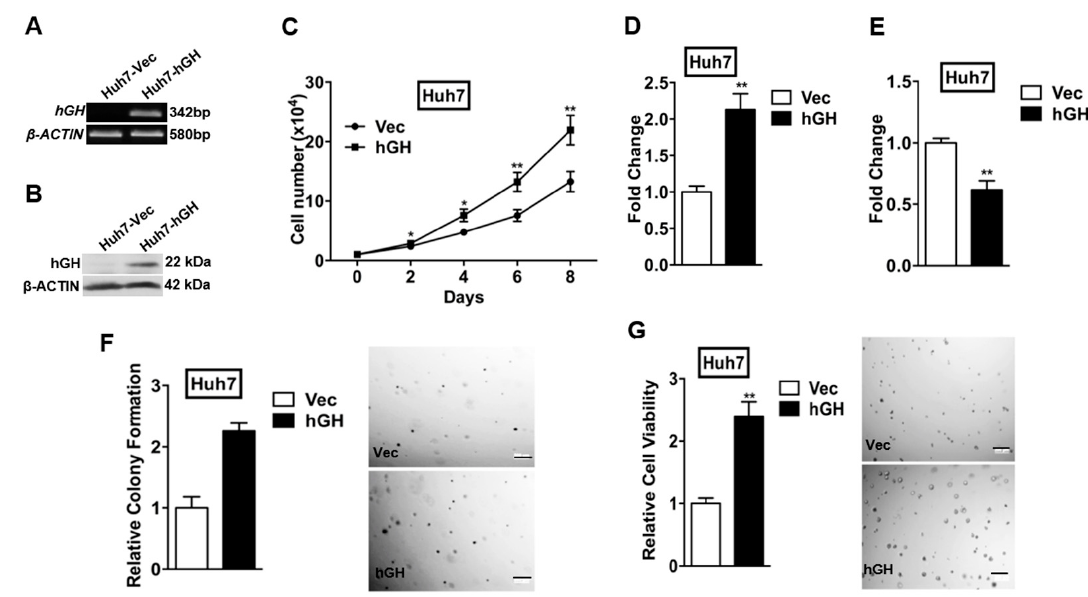
Figure 1. Forced expression of hGH promotes cell proliferation, cell survival, and anchorage-independent growth in human HCC cells. Huh7 cells were stably transfected with an expression vector containing the human growth hormone ( hGH ) gene (designated Huh7-hGH) or pcDNA vector alone (Huh7-Vec). The expression levels of hGH in Huh7-hGH and Huh7-Vec cell lines were determined by: ( A ) reverse transcription polymerase chain reaction (RT-PCR), and ( B ) Western blot. β -ACTIN was used as input control; ( C ) Growth of Huh7-Vec and Huh7-hGH cells were determined by total cell number assay in medium supplemented with 10% fetal bovine serum (FBS). * p < 0.05; ** p < 0.01; ( D ) Effect of forced expression of hGH on cell cycle progression was assessed by 5-bromo-2 ′ -deoxyuridine (BrdU) incorporation in medium supplemented with 10% FBS; ( E ) Effect of forced expression of hGH on cell apoptosis was determined by measuring caspase 3/7 activity of Huh7-Vec and Huh7-hGH cell lines after 24 h serum-deprivation. ** p < 0.01; ( F ) The anchorage independent growth of Huh7 cells by forced expression of hGH was assessed by soft agar colony formation in 10% FBS medium. Cell colonies were visualized by 3-(4,5-dimethylthiazol-2-yl)-2,5-diphenyltetrazolium bromide (MTT) staining. Bar, 200 µm; ** p < 0.01; ( G ) Effect of forced expression of hGH on the growth of Huh7 cells on growth factor-reduced Matrigel™. Huh7-Vec/hGH cells were seeded in 4% Matrigel™ into 96-well plates pre-coated with Matrigel™. Cell viability was measured using MTT assay after 7 days. Bar, 200 µm; ** p < 0.01.